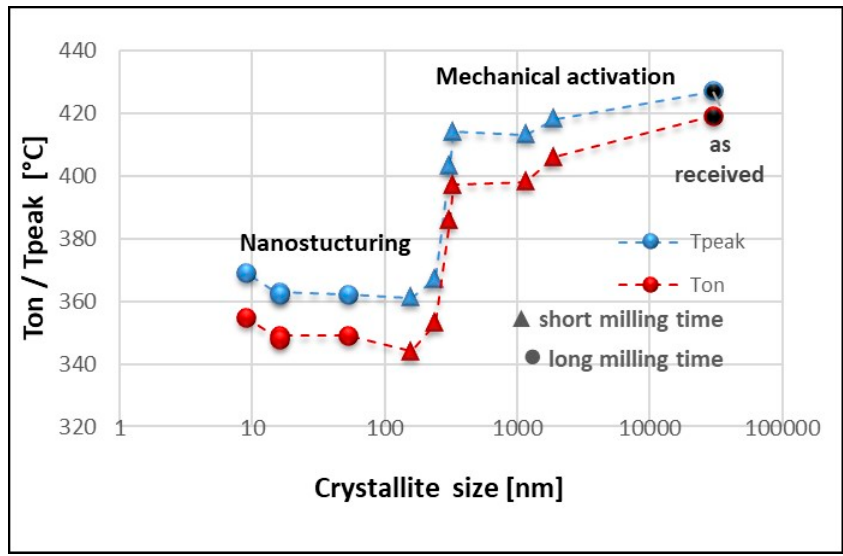
Figure 6. The changes in decomposition temperature for MgH 2 vs. crystallite size.